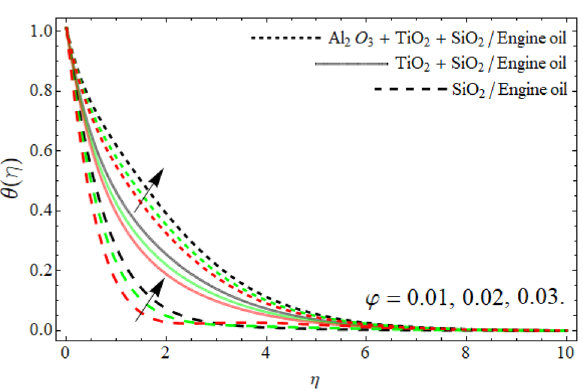
Figure 11. The energy profile θ(η) outlines versus ternary nanoparticles ϕ